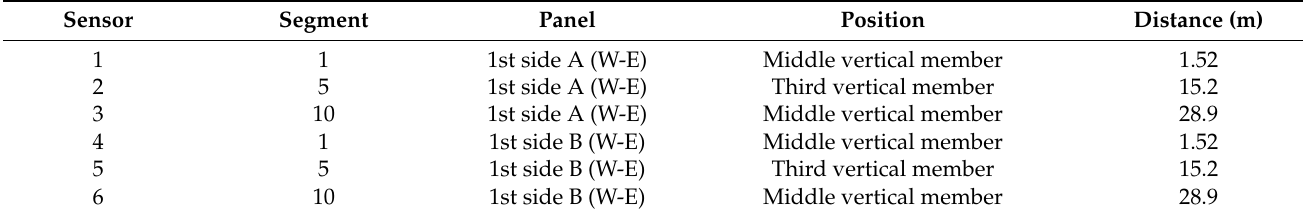
Table 8. Sensor positioning